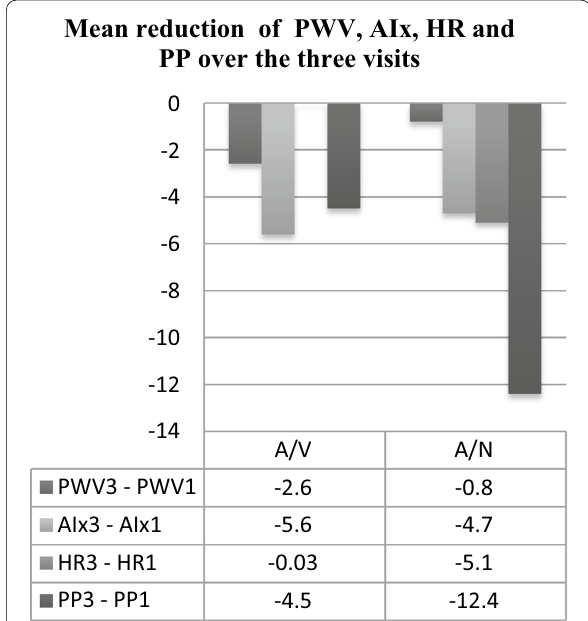
Fig. 3 Mean differences of central hemodynamics within the same group and between